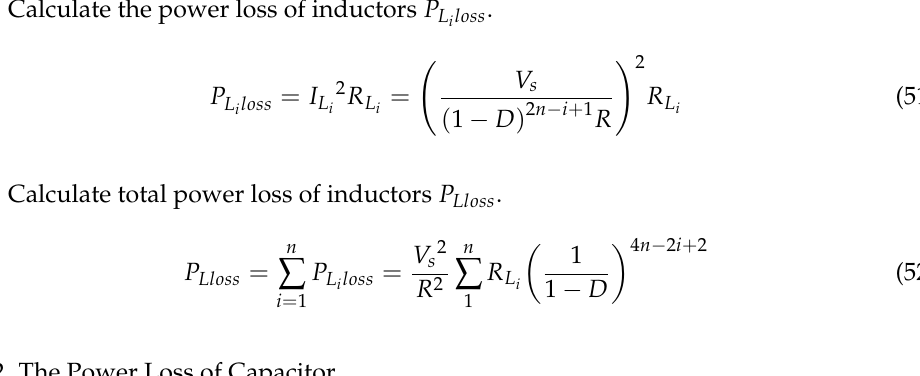
Figure 7. The value of V D I out = 1